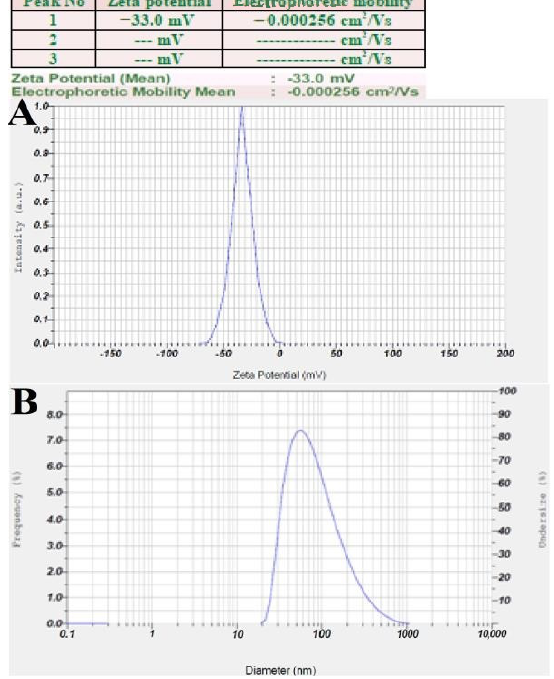
Figure 7. ( A ) Zeta potential analysis graph. ( B ) Size intensity analysis graph of synthesized RsFb-AgNPs.